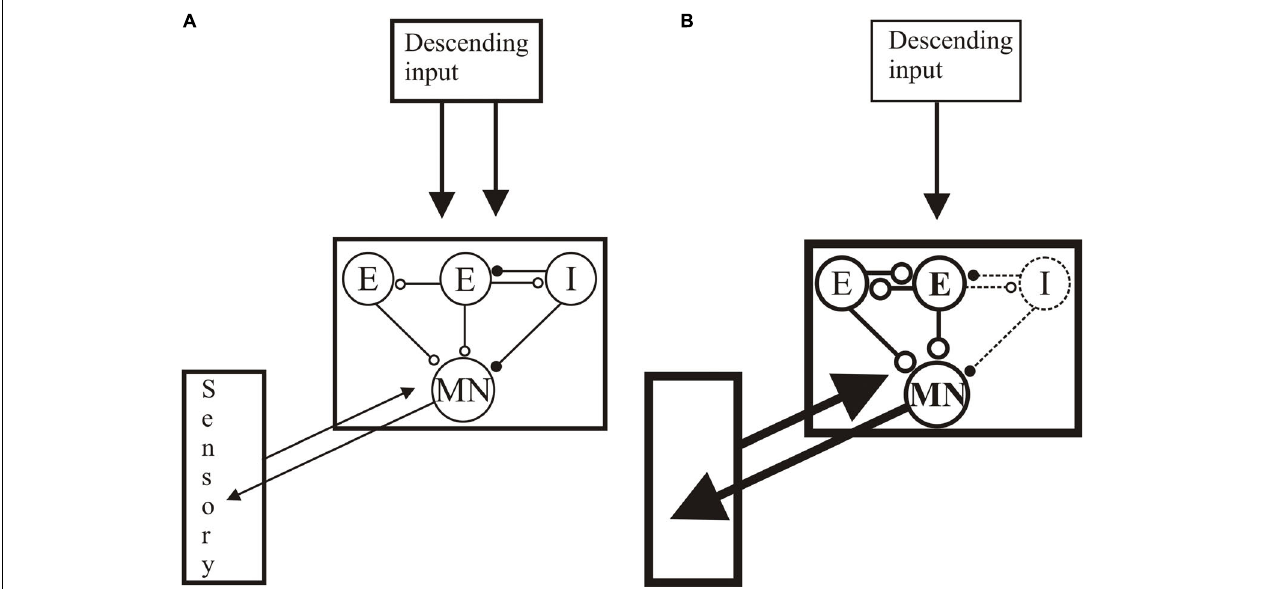
FIGURE 10 | Summary of changes after lesioning. (A) The unlesioned network. Descending inputs project to the locomotor network. The network scheme is simplified to focus on known aspects, essentially limited to one half-center or hemisegmental network (open circles are glutamatergic synapses, filled circles are glycinergic synapses). Two hemisegmental networks in each spinal segment control activity on the left and right sides of the body, and are coupled by reciprocal inhibitory connections, the nature of which remains uncertain (Parker, 2006). The hemisegmental network contains EINs that provide glutamatergic inputs to other EINs, motor neurons, and the small ipsilateral inhibitory interneurons (SiIN): the latter provide feedback inhibition to the EINs and feedforward inhibition to motor neurons (this circuitry has been characterized in adults (Jia and Parker, 2016)). Movement is detected by proprioceptive edge cells that provide feedback to the locomotor network. (B) General summary of the changes after injury: see text for details of above/below, good/poor recovery, and larval/adult changes. Thicker lines represent increased activity, thinner reduced. Descending inputs to the spinal cord are reduced in number but individual connections are unaltered after lesioning. In the locomotor network there are changes in the cellular properties of EINs and motor neuron (larvae) and the connectivity and synaptic properties of the EINs (larvae and juveniles). Connections to the SiINs seem a key difference, with increased activity associated with poor recovery in larvae but with good recovery in adults. Sensory inputs are also increased after